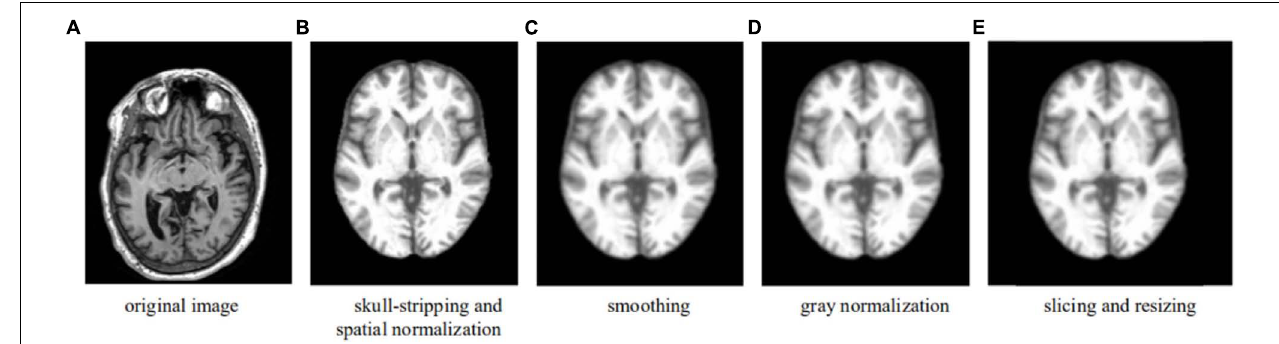
FIGURE 1 | Preprocessing pipeline—an example showing the formation of a transverse slice used in the learning. (A) Original image. (B) Skull-stripping and spatial normalization. (C) Smoothing. (D) Gray normalization. (E) Slicing and resizing.